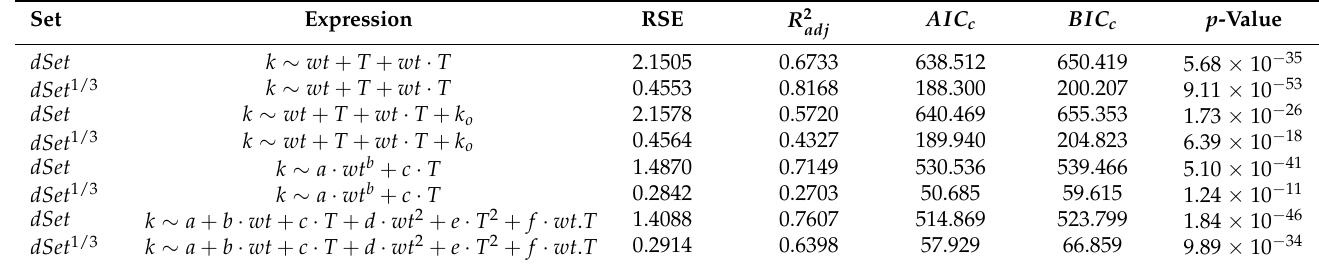
Table 16. Regression results for k as a function of wt and T for the AS dataset.